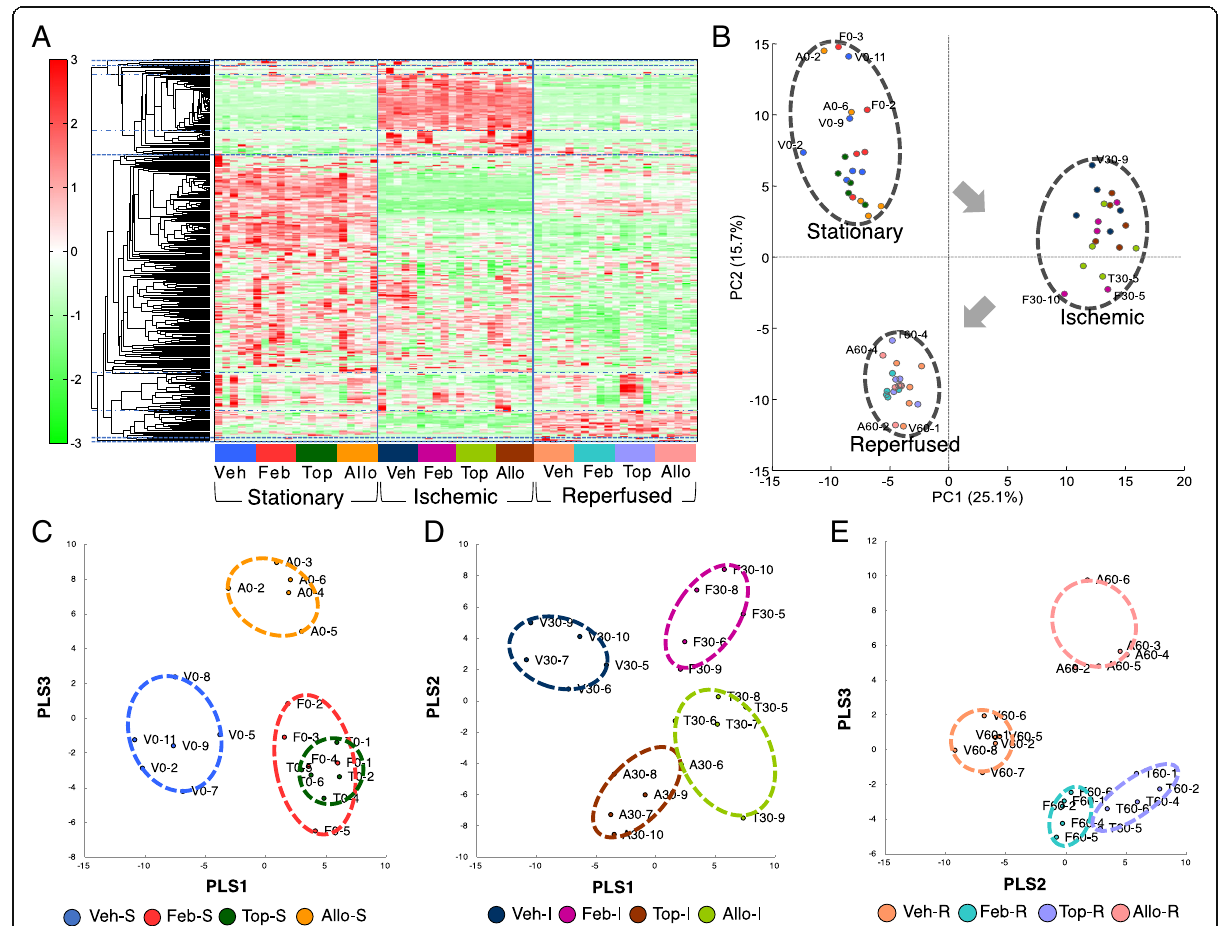
Fig. 5 Heatmap, PCA and PLS-ROG analysis. a Heat map analysis of all samples showed that the kidney metabolic profile was altered mainly by I/ R injury rather than XOR inhibitor interventions. b PCA results coincided with heat map data in that PC1 and PC2 clearly distinguished metabolic alterations by hemodynamic changes; each of the stationary, ischemic, and reperfused states formed a separate cluster. Partial least squares with rank order of groups (PLS-ROG) analysis of samples in the stationary, ischemic and reperfused states. c Based on PLS-ROG analysis in the stationary state, febuxostat-treated (Feb-S) and topiroxostat-treated (Top-S) samples show rather similar metabolic alterations but different from those in the two other groups. Vehicle-treated samples (Veh-S) had a metabolic profile distinguishable from those of XOR inhibitor-treated groups (Feb-S, Top-S, and Allo-S) by factor loadings for PLS1. Allopurinol-treated samples (Allo-S) were distinguishable from the other groups by factor loadings for PLS3. d In the ischemic state, vehicle-treated samples (Veh-I) had a metabolic profile distinguishable from those of XOR- inhibitor-treated groups (Feb-I, Top-I, and Allo-I) by factor loadings for PLS1. e In the reperfused state, vehicle-treated samples (Veh-R) had a metabolic profile distinguishable from those of XOR-inhibitor treated groups (Feb-R, Top-R, and Allo-R) by factor loadings for PLS2. Allopurinol- treated samples (Allo-R) were distinguishable from the other groups by factor loadings for